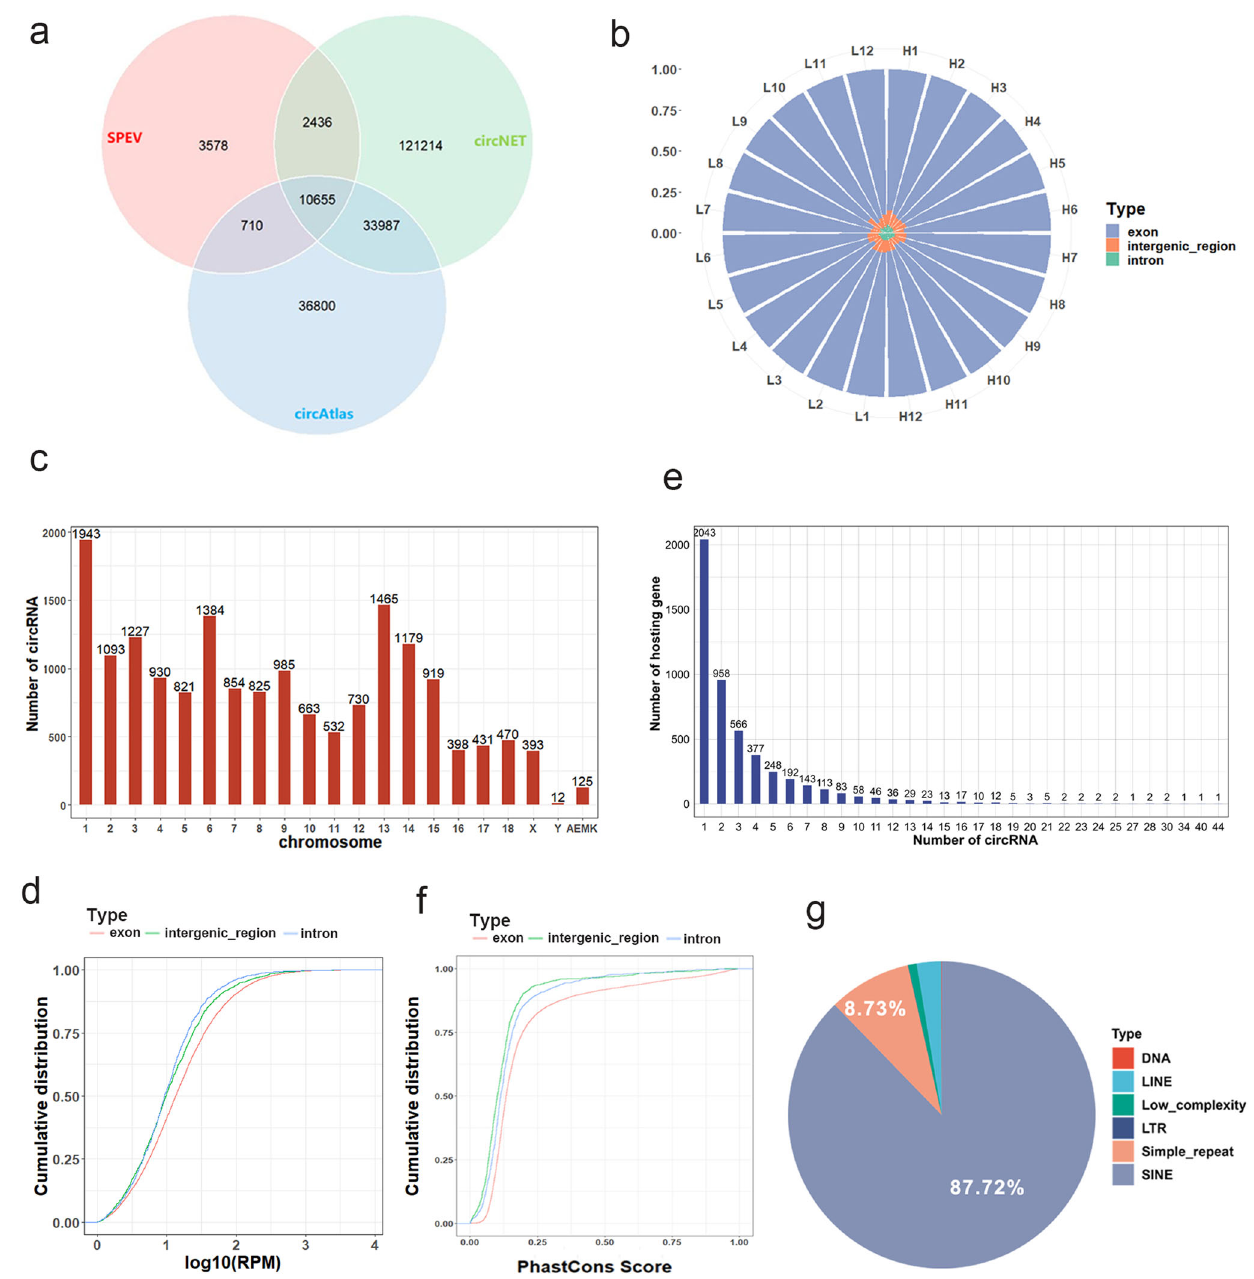
Fig. 2 Identi fi cation and characterization of circRNAs in SPEVs. a Venn diagram of circRNAs identi fi ed in the current study and porcine circRNAs contained in the circAtlas and circNET databases. b The proportions of exonic circRNAs, intronic circRNAs and intergenic region circRNAs in all samples. H represents high sperm motility group and L represents low sperm motility group. c The number of identi fi ed circRNAs in each chromosome. d Cumulative expression distribution of three different types of circRNAs. e Distribution of host genes encoding different numbers of circRNA isoforms. f Distribution of conservation scores of different types of circRNA. g The reverse complementary matches (RCMs) in the fl anking sequences of back-splice junction (BSJ) sites of exonic